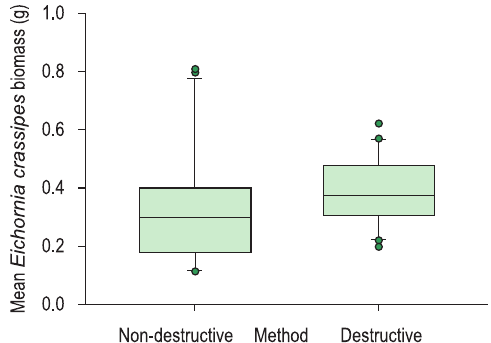
Figure 3. Boxplot of the biomass determination by non- destructive and destructive methods.